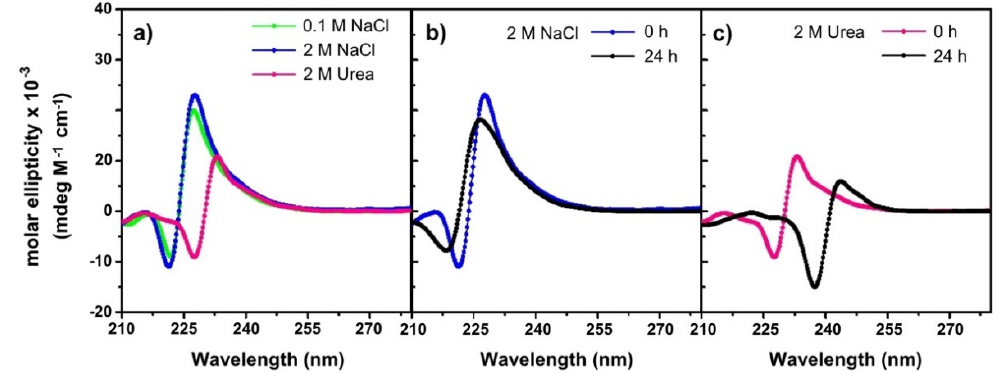
Figure 4. M- l -Gln CD spectra dependence on: ionic strength (0.1 M and 2 M NaCl), panels ( a ) and ( b ); denaturing agent (urea), panels ( a ) and ( c ). Data obtained at 25 °C, pH 8.0 in 0.1 M NaCl with a repeat unit concentration of 1.66 mM.